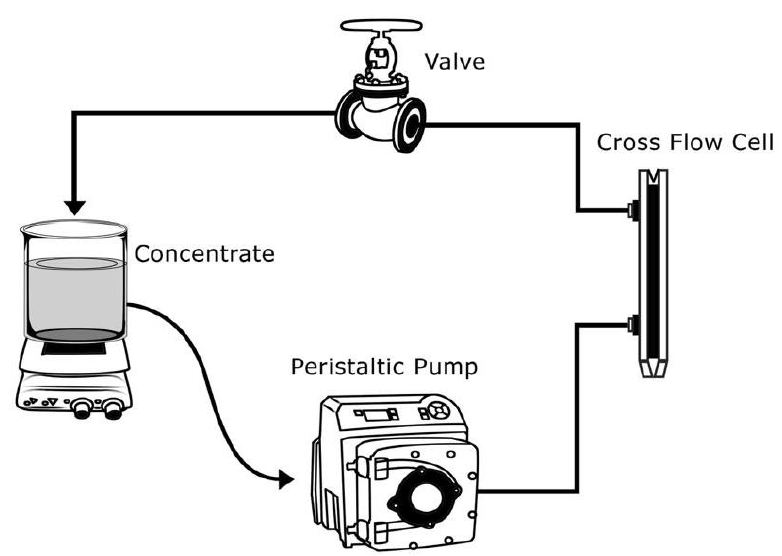
Figure 2. Schematic of the leaching study setup .